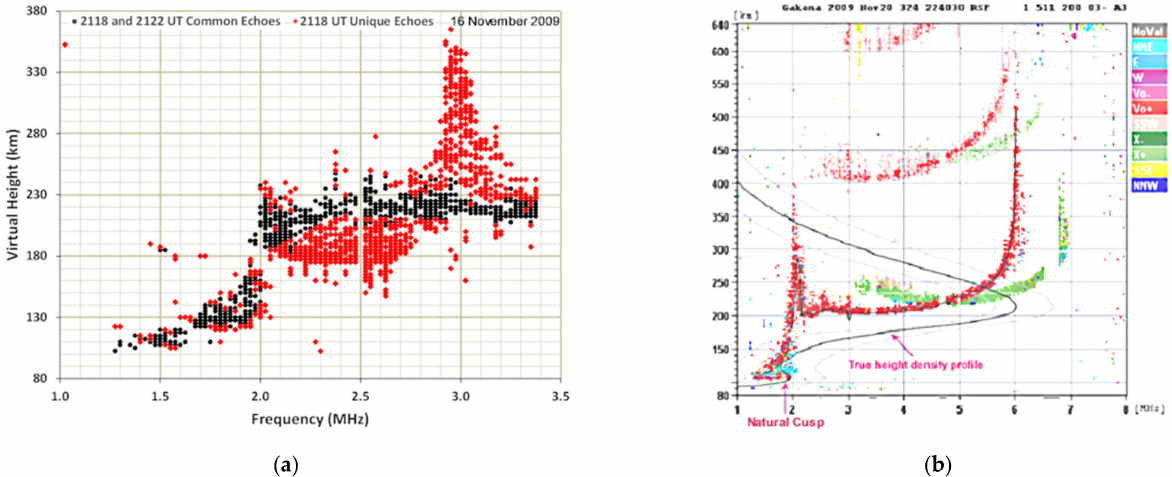
Figure 7. ( a ) The unique echoes (red triangles) extracted from the 21:18 UT ionogram and (black dash) the common echoes of 21:18 UT and 21:22 UT ionograms, recorded during heating experiment conducted on 16 November 2009, and ( b ) an ionogram showing that the natural cusp near foE (the peak plasma frequency of the ionospheric E region) in the density distribution causes spread of the sounding echoes to also appear as a